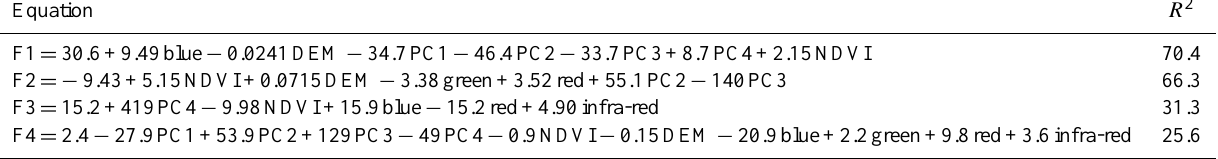
Table 5. Multiple linear regression models relating factor axes scores (F1–4) to imagery derived variables: four spectral bands (blue, green, red and infra-red), Normalized Difference Vegetation Index (NDVI), Principal Component transformation to the IKONOS-2 image (PC), and canopy topography derived from DEM-SRTM (DEM). R 2 is the coefficient of determination showing the strength of these relationships.